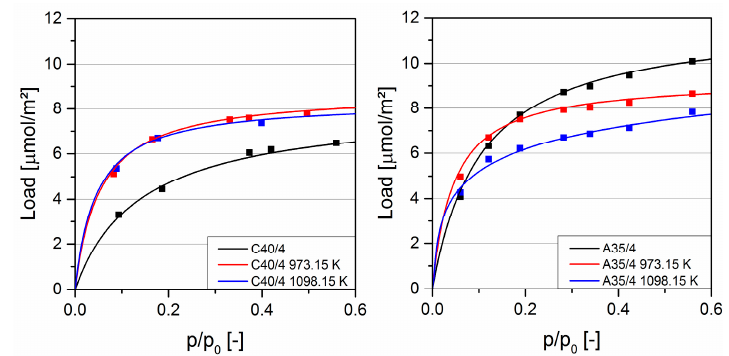
Figure 4. Thermogravimetric balance (TGA) adsorption measurements of ethanol at 298.15 K (symbols: measuring data (Table S3), lines: fitted Langmuir isotherm (Table S2)).